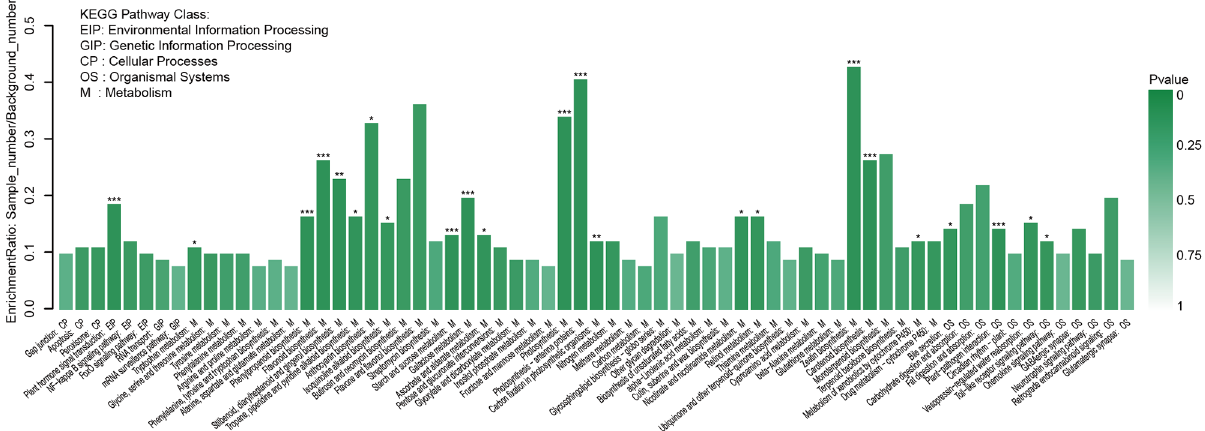
Fig 8. Histogram of KEGG enrichment distribution of DEG. P-value < 0.001was marked (cid:3)(cid:3)(cid:3) , P-value < 0.01 was marked (cid:3)(cid:3) , P-value < 0.05 were marked (cid:3) .